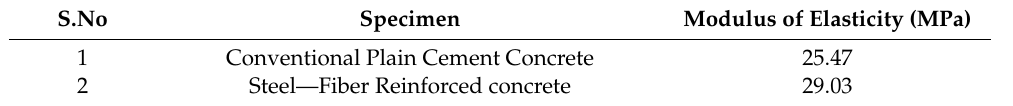
Table 6. Modulus of elasticity of specimens.